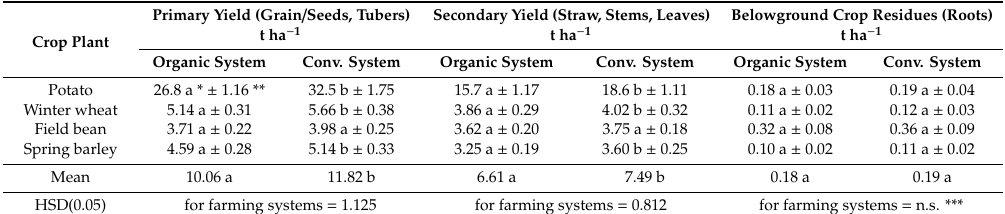
Table 7. Primary yield, secondary yield, and belowground crop residues of plants in a 4-field crop rotation in the organic and conventional